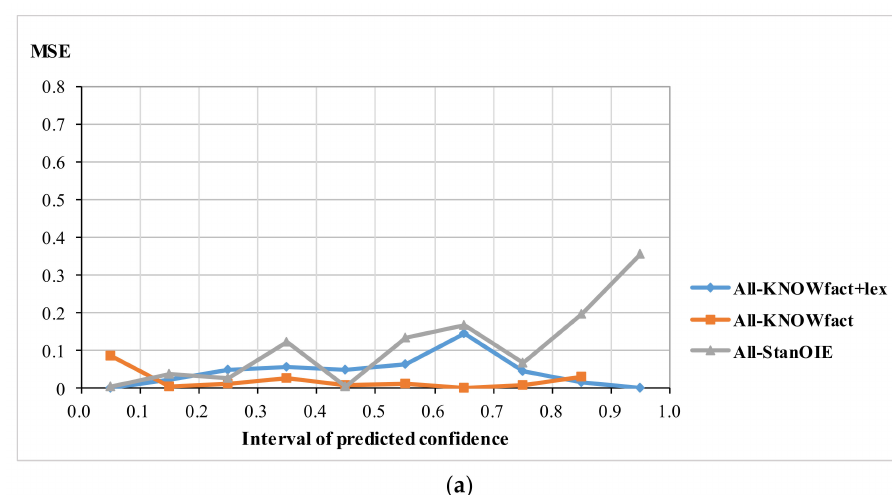
Figure 3. ( a ) MSE for all samples; ( b ) MSE for semantic relation samples; ( c ) MSE for spatial relation